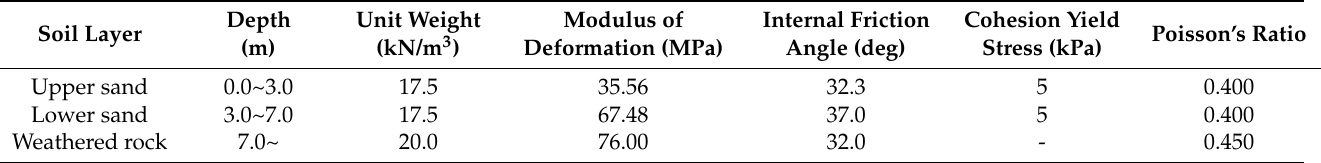
Table 3. Soil profile of survey site.